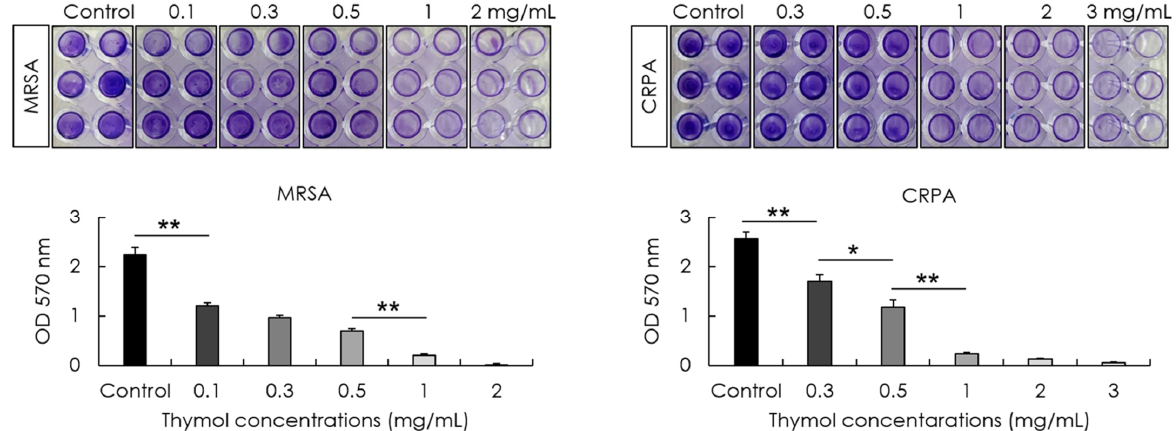
Figure 3. The activity of thymol against the formation of biofilms produced by methicillin-resistant Staphylococcus aureus (MRSA) and ciprofloxacin-resistant Pseudomonas aeruginosa (CRPA). Biofilm formation was examined following 24 h exposure to thymol. Thymol significantly inhibited the rates of MRSA and CRPA biofilm formation in a concentration-dependent manner. Data are shown as the means ± standard errors of the mean of five independent experiments (** p < 0.01, * p <